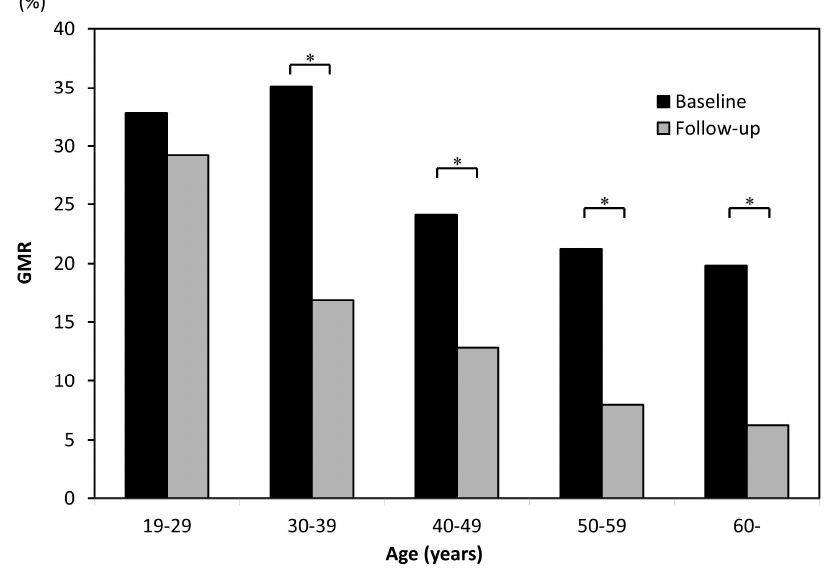
Figure 5. A comparison of the mean GMR scores of former smokers at baseline and follow-up, grouped according to age * p < 0.05 (paired t ‐ test).